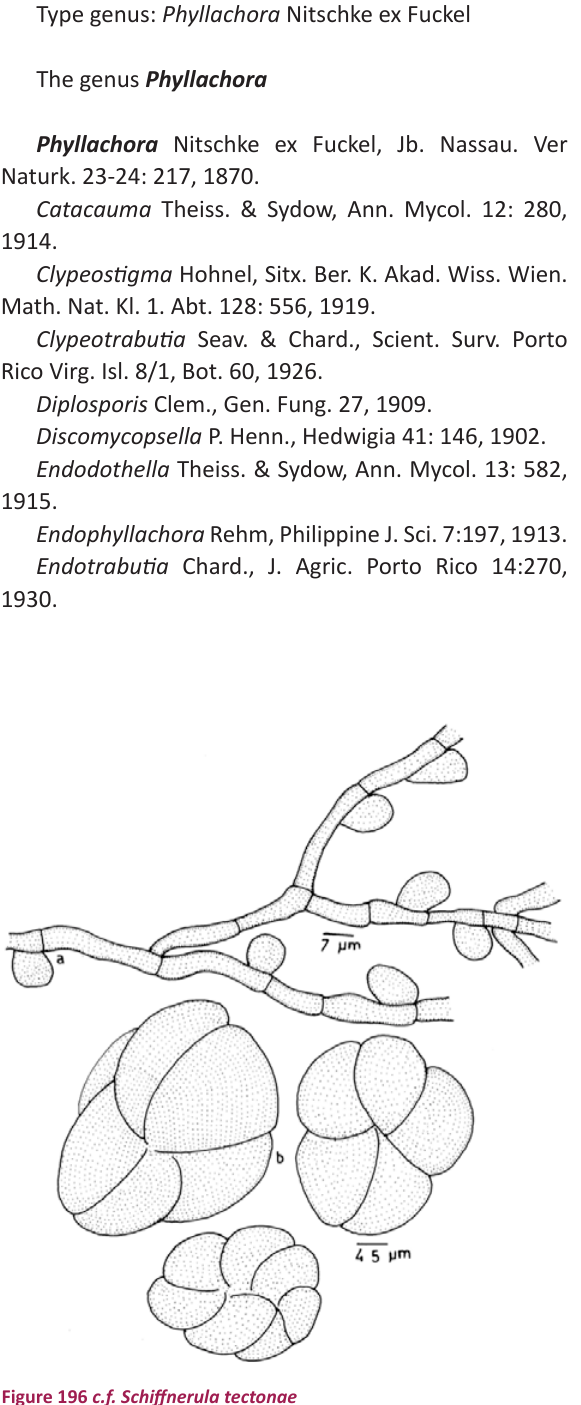
Figure 196 c.f. Schiffnerula tectonae a - Appressoriate mycelium; b - Sarciniform